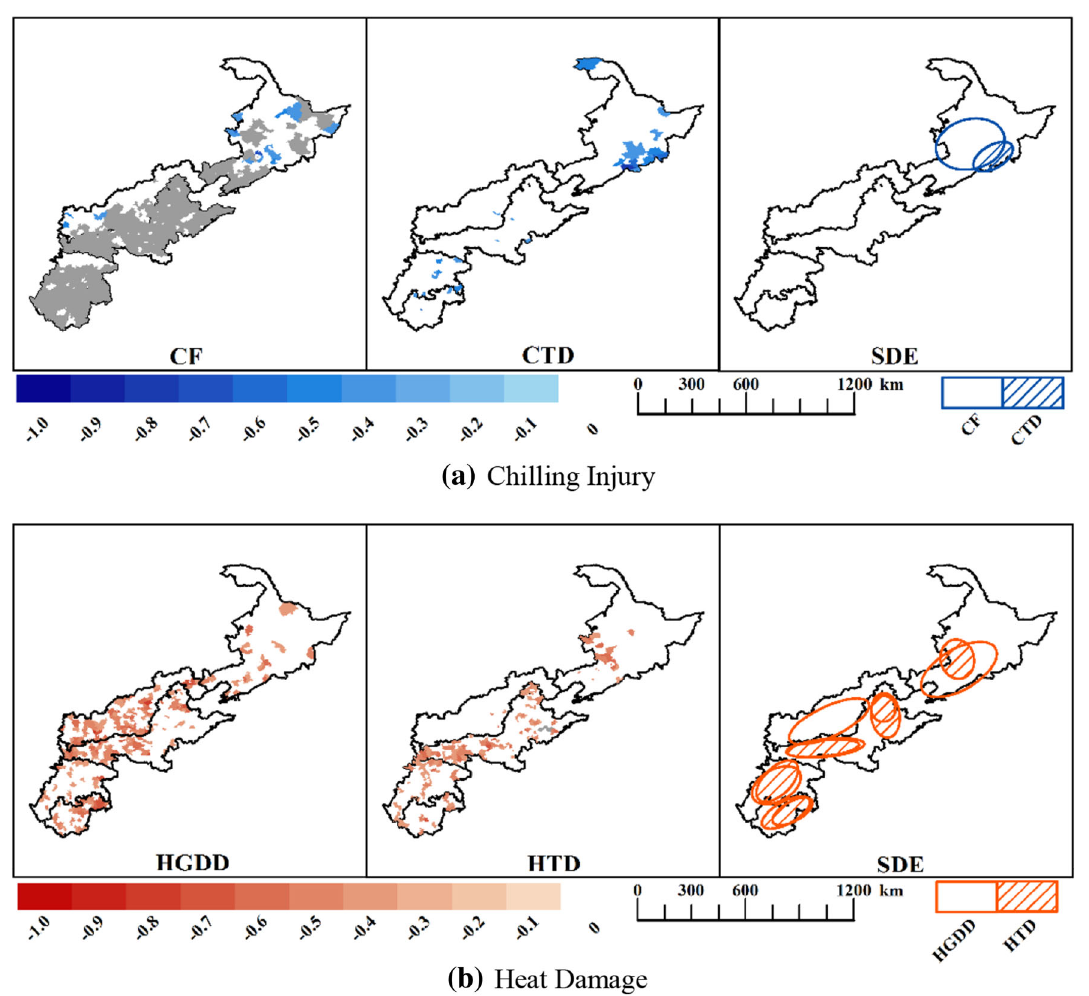
ellipses relative weather indices. Negative values of R indicate disasters resulting in yield